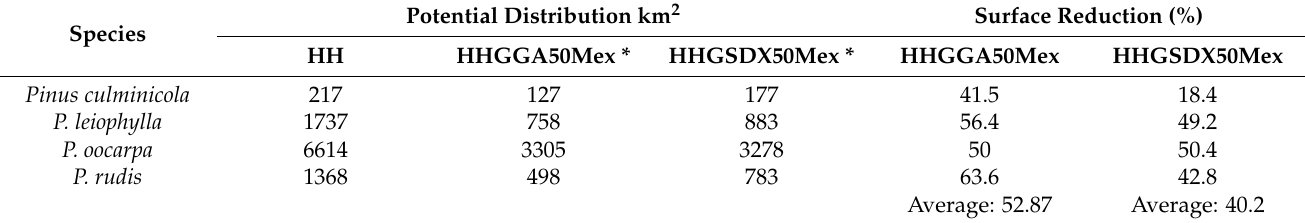
Table 1. Changes in the potential distribution of Pine species under future severe (HHGGA50) and conservative (HHGSDX50) climate change